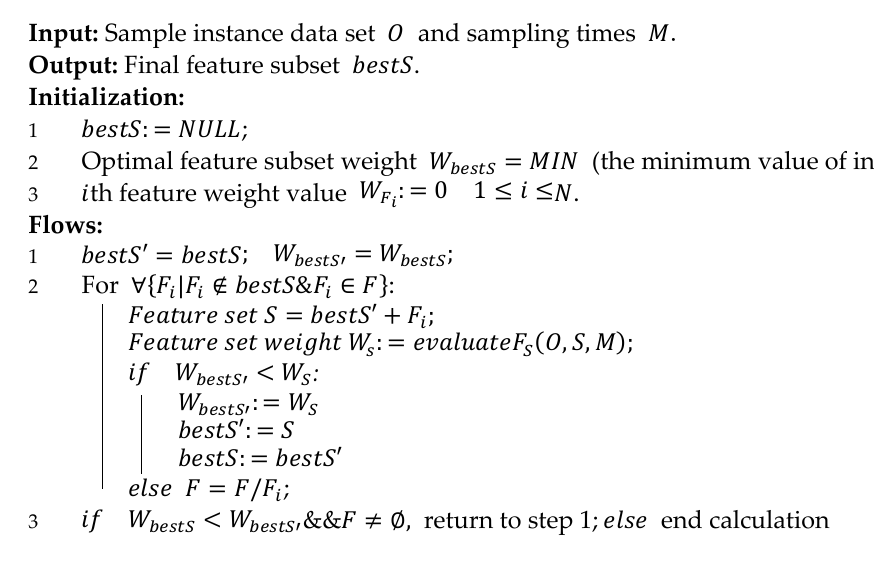
Algorithm 2: FSIRW feature selection algorithm